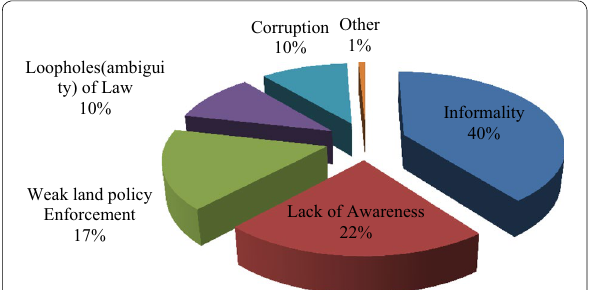
Fig. 7 Challenges of land administration practices in Jimma city (Source: Field Survey